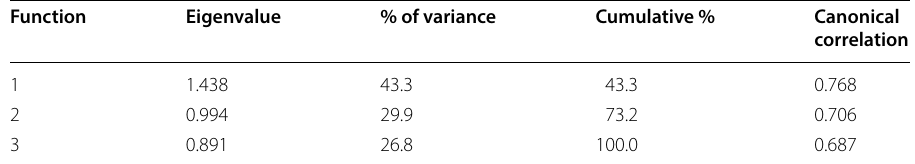
Table 10 Eigenvalues of functions Function